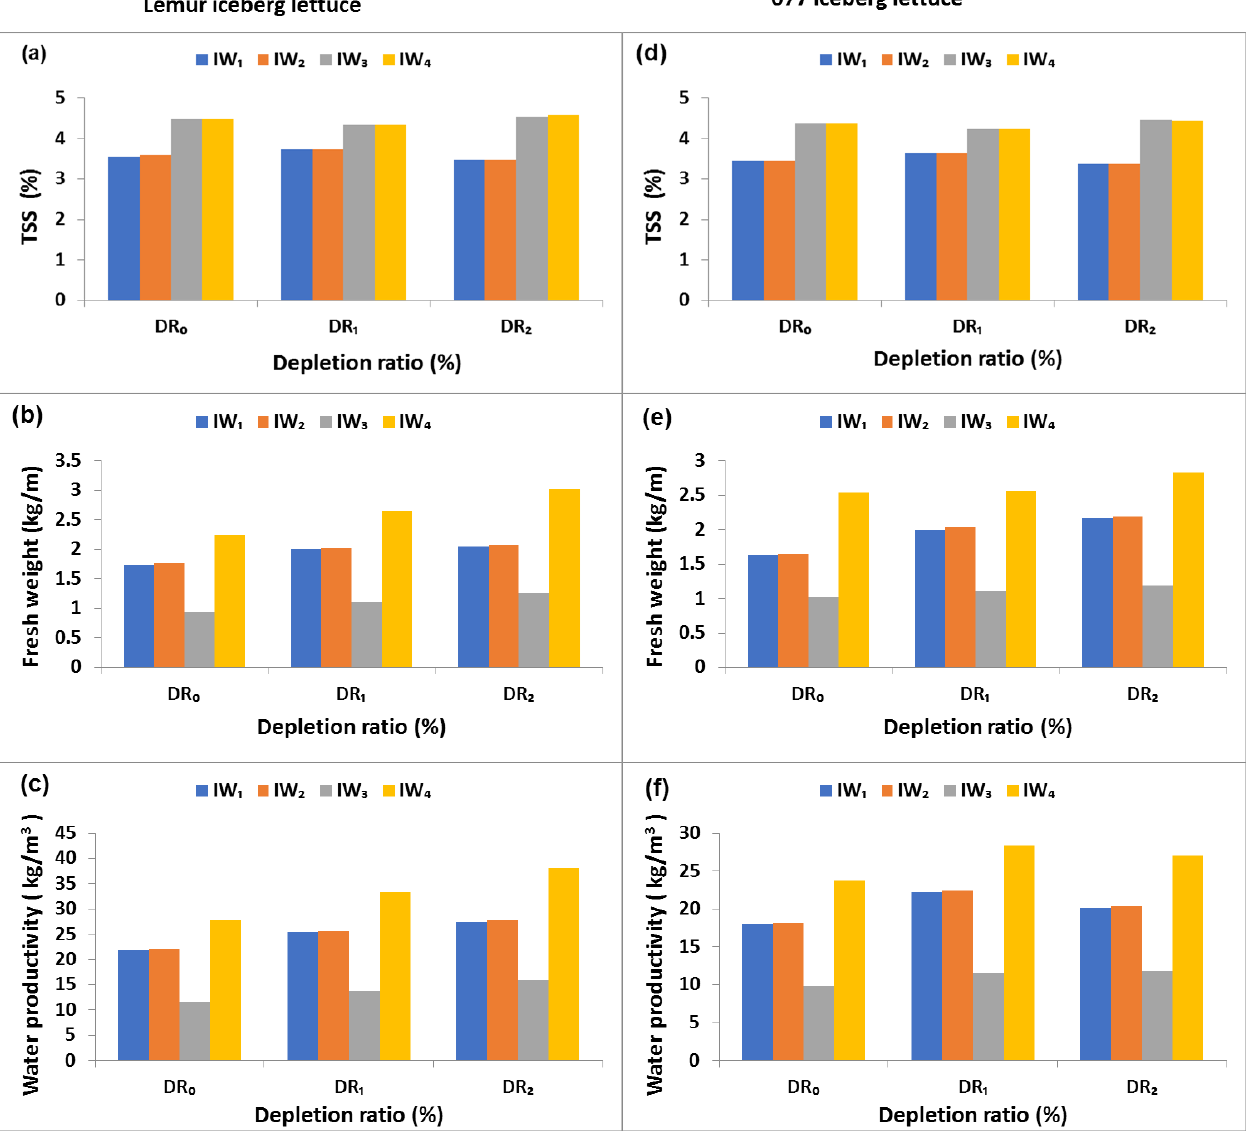
Figure 3. Interaction between irrigation water type and depletion ratio on ( a , d ) total soluble solids (TSS), ( b , e ) fresh weight and ( c , f ) water productivity of lemur and 077 cultivars, respectively. IW 1 refers to common irrigation water, IW 2 represents magnetically treated common irrigation water, IW 3 represents saline water and IW 4 represents magnetically treated saline water. DR 0 , DR 1 and DR 2 represents the depletion ratio at 50%, 60% and 70%, respectively.